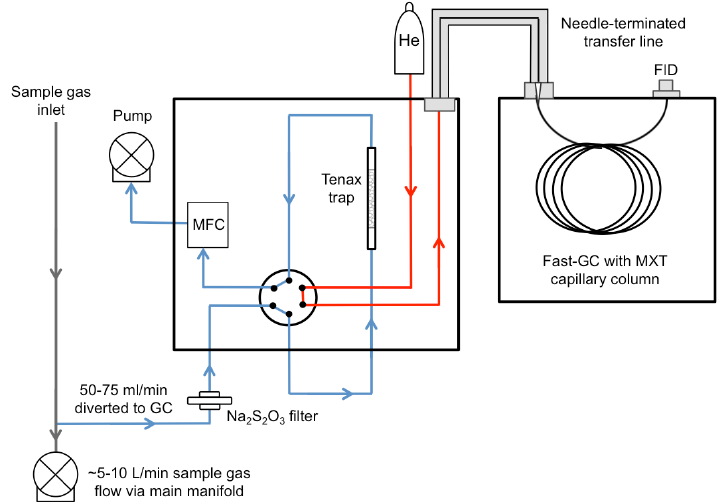
Fig. 1. Schematic of the Fast-GC instrument, thermal desorber and needle-terminated transfer line, in the air sampling configuration. The sample gas flow path is illustrated in blue; helium carrier gas flow within the thermal desorber is shown in